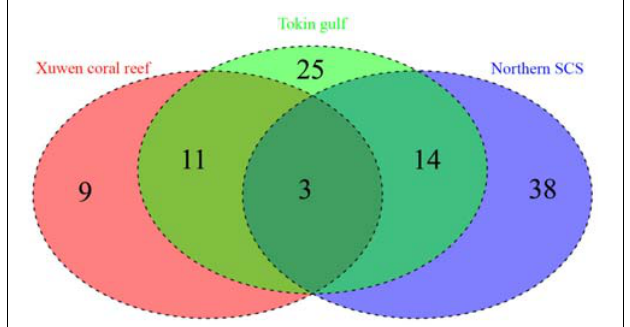
FIGURE 3 | Venn diagram for the Xuwen Coral Reef, Gulf of Tonkin, and northern